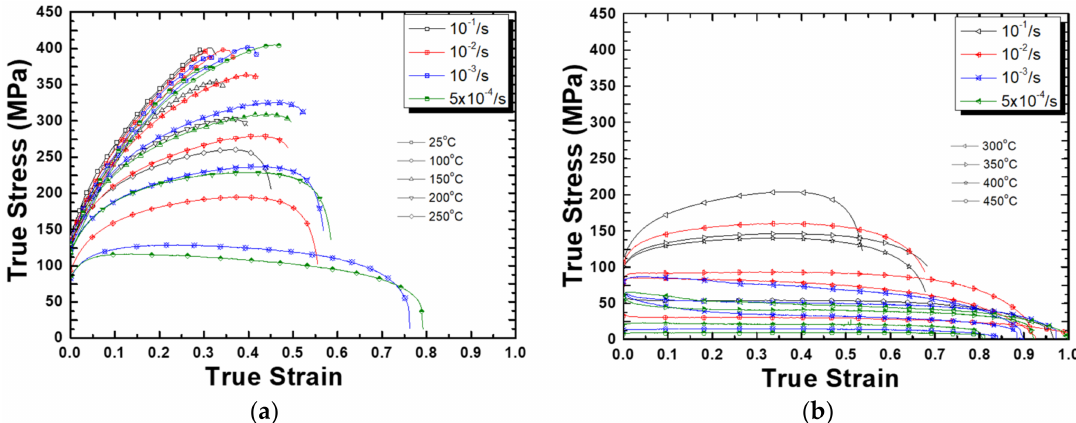
Figure 1. The true stress-true strain curves of the 5182 alloy obtained from the tensile tests performed in the temperature range ( a ) between 25 and 250 ◦ C and ( b ) between 300 and 450 ◦ C at different strain